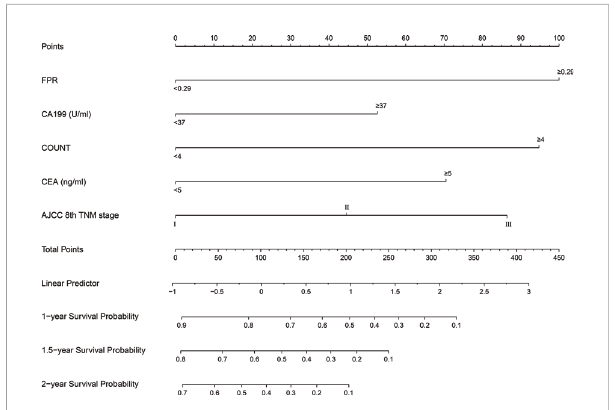
FIGURE 4 Survival nomogram for patients with resectable pancreatic